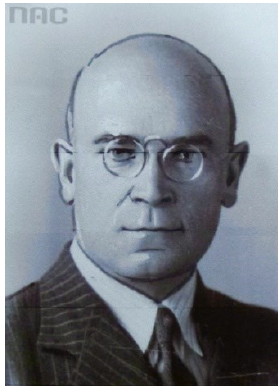
Figure 3. Józef Borowik (1891–1968) was an ichthyologist, who published a book on Fish Physiology in 1922 [9]. Here it is mentioned that fish leukocytes can “eat” bacteria. Borowik became a successful director of the Baltic Institute at Gdańsk (Poland) during the years 1927–1950 (with a break during World War II). His picture was obtained from Narodowe Archiwum Cyfrowe (NAC, National Digital Archives), Warsaw (Poland) and is used with